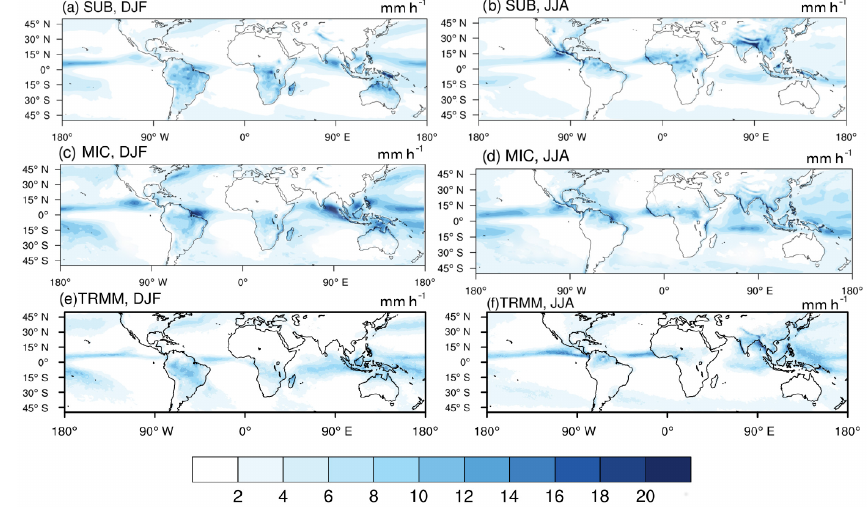
Figure 2. Simulated 10-year mean precipitation (mmh − 1 ) for DJF (left) and JJA (right) in SUB and MIC runs (top two panels) and OBS (bottom); TRMM data represent OBS. Table 1. Description of simulation